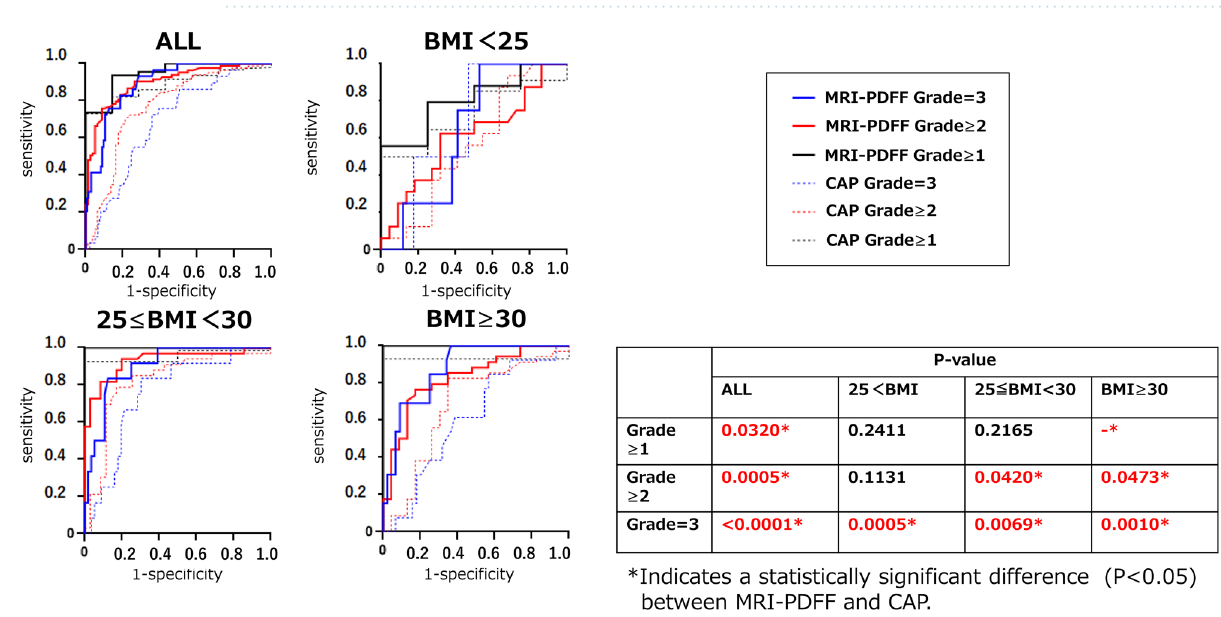
Figure 4. Comparison of the diagnostic accuracy of VCTE and MRI/MRE techniques to detect liver fibrosis in patients with NAFLD presented by AUROCs. MRE magnetic resonance elastography, MRI magnetic resonance imaging, VCTE vibration-controlled transient elastography, AUROC area under the receiver operating